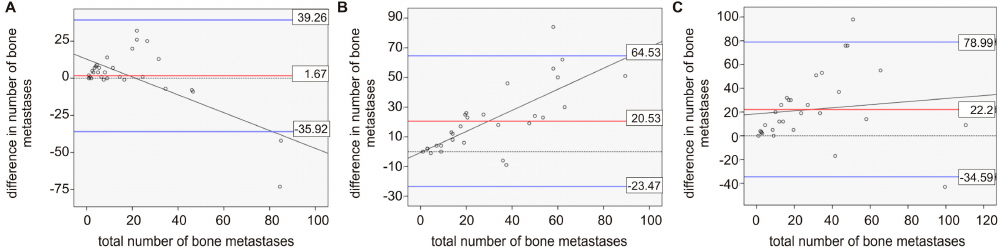
Figure 2. Bland-Altman plot including the linear trend of the comparison of ( A ) visual analysis of bone scans and semiautomatic analysis (EXINI) of bone scans, ( B ) visual analysis of bone scans and [ 68 Ga]Ga-PSMA-PET/CT, ( C ) semiautomatic analysis of bone scans (EXINI) and [ 68